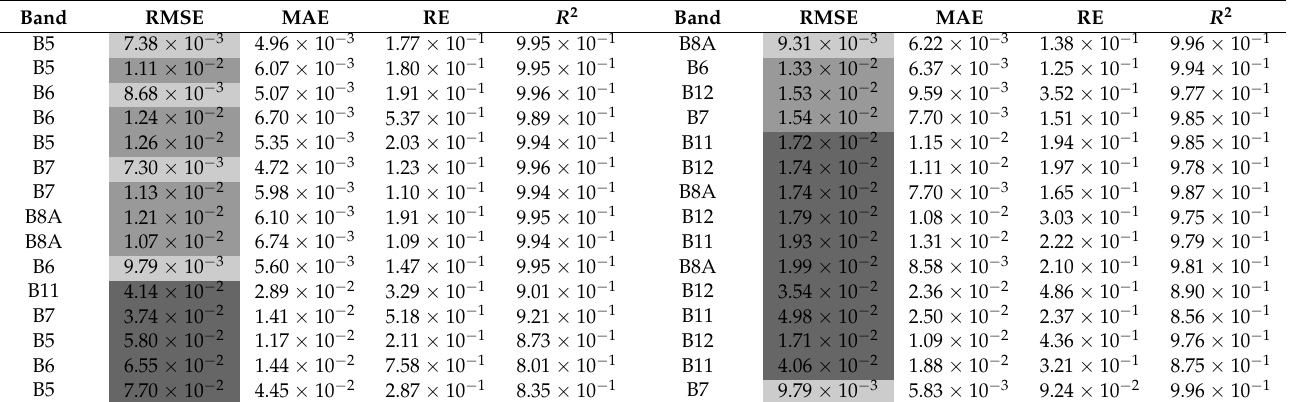
Table 16. Double-band regression results for L2A. The colors in the RE (relative error) columns indicate whether the specification is fulfilled (light gray), nearly fulfilled (middle gray) or unfulfilled (dark